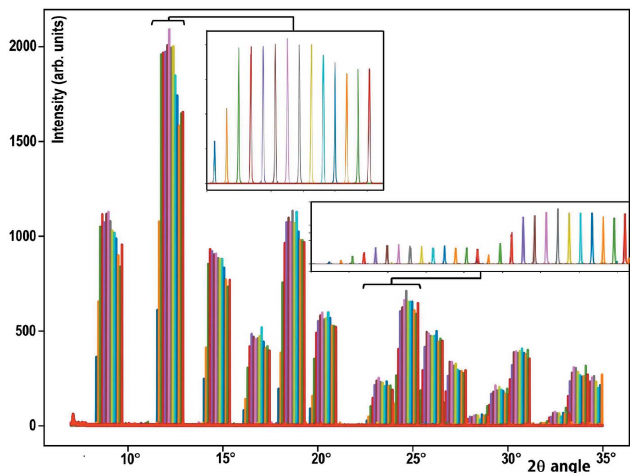
Figure 9 Diffraction patterns of a LaB 6 sample filtered by each analyser crystal of the Si(111) single-crystal-comb MAD block associated with the Soller- colimator block (one colour for each analyser). The two enlargements detail the signals received for three LaB 6 reflections after their filtering by each 14 analyser crystals with an angular pitch of 0.1 (cid:3)